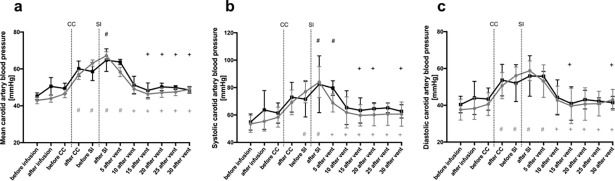
Mean (a), systolic (b) and diastolic (c) carotid artery blood pressure in caffeine treated (grey dots) and control (black squares) lambs. The figure shows mean± SEM values at different time points during the experiment: before caffeine/ saline infusion; after caffeine/ saline infusion; before cord clamping (CC); after CC; before sustained inflation (SI); after SI; 5, 10, 15, 20, 25 and 30 minutes after ventilation onset. # indicates significant difference compared to “before CC” (grey within caffeine group, black within saline group). + indicates significant difference compared to “after SI” (grey within caffeine group, black within saline group).